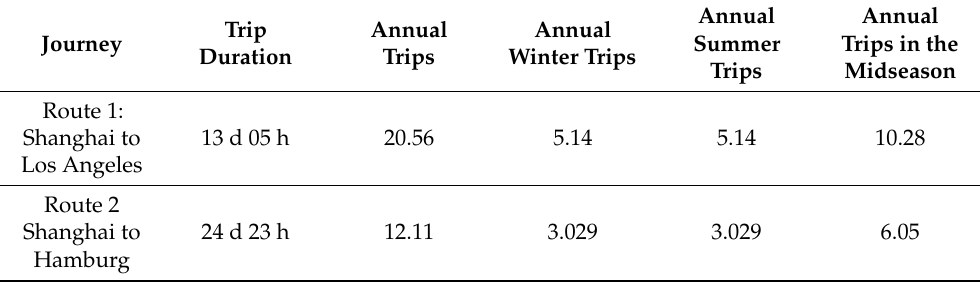
Table 5. Numbers of journeys per year and per each